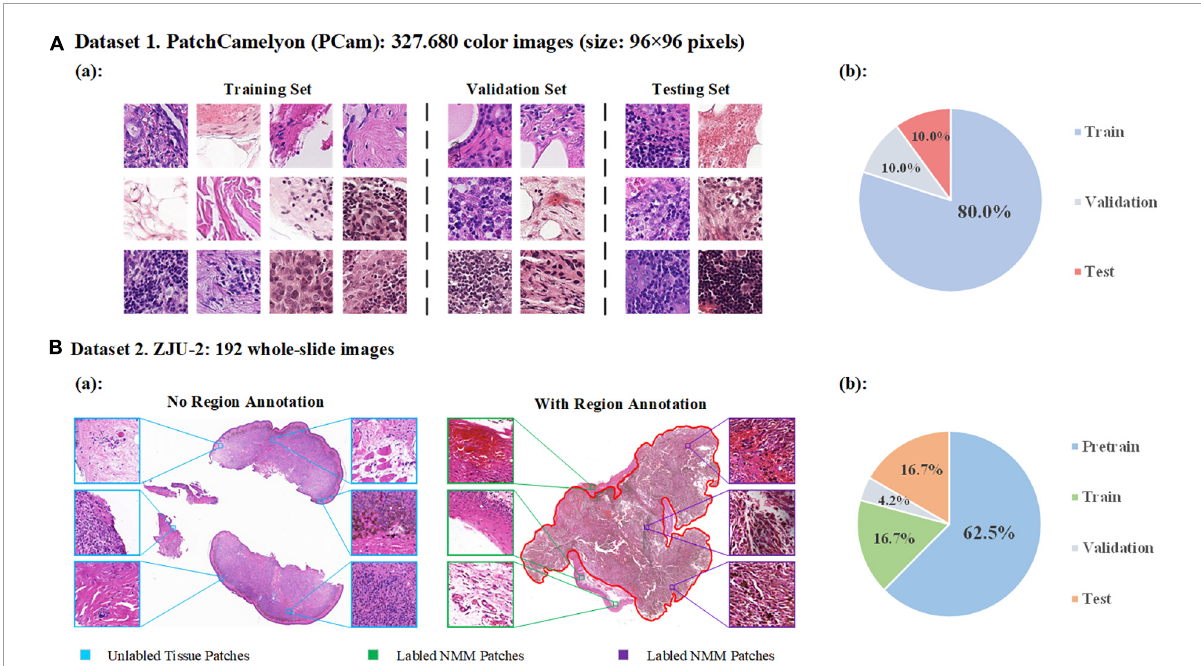
FIGURE2 Data distribution. (A) Detailed data of PatchCamelyon (Pcam). (a) Examples of images in PatchCamelyon. (b) The data of original image grouping. (B) Dataset of ZJU-2. (a) Examples of pathological digitized WSIs with or without annotations and patches from WSIs. (b) Patches are divided into four sets: pretraining, training, validation, and testing sets.